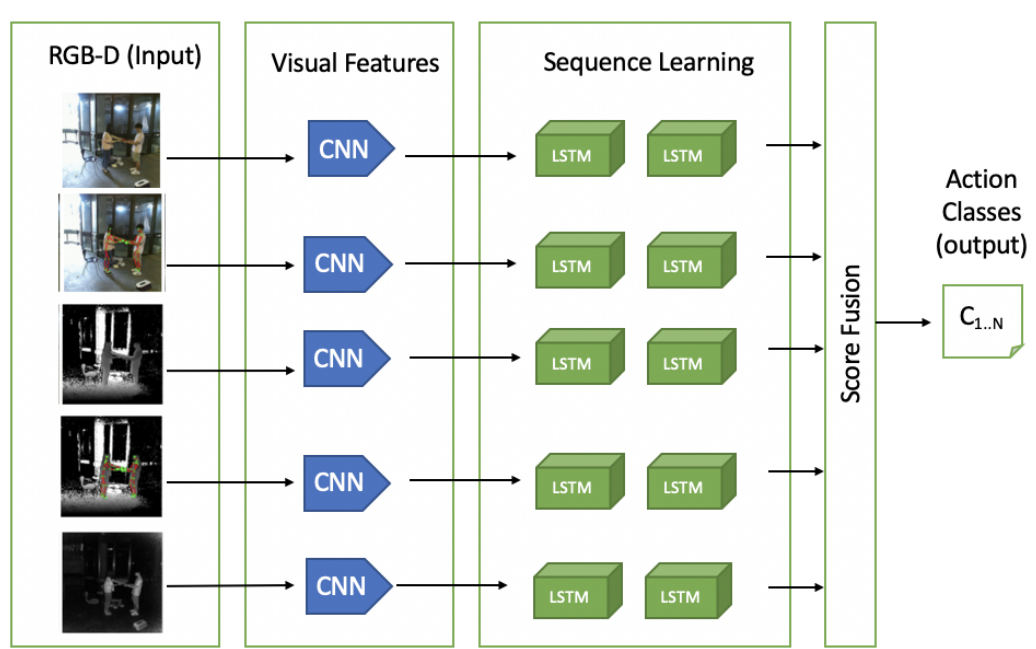
Figure 6. A possible architecture of LRCN with RGB-D input. Input from each modality, i.e., RGB, RGB + Skeleton joints, Depth, Depth + Skeleton joints, and IR are passed through a CNN layer for extracting visual features and an LSTM layer for sequence learning. Scores from each model are then fused and mapped to the number of classes for predictions. Visuals of RGB-D input are taken from NTU RGB-D 60 dataset